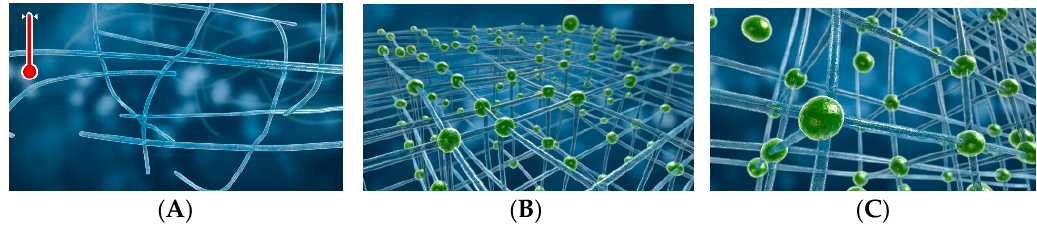
Figure 1. The eXcellent three-dimensional reticulation (XTR ™ ) technology manufacturing process. ( A ) The pretreatment phase. ( B ) The crosslinking phase. ( C ) The purification process.